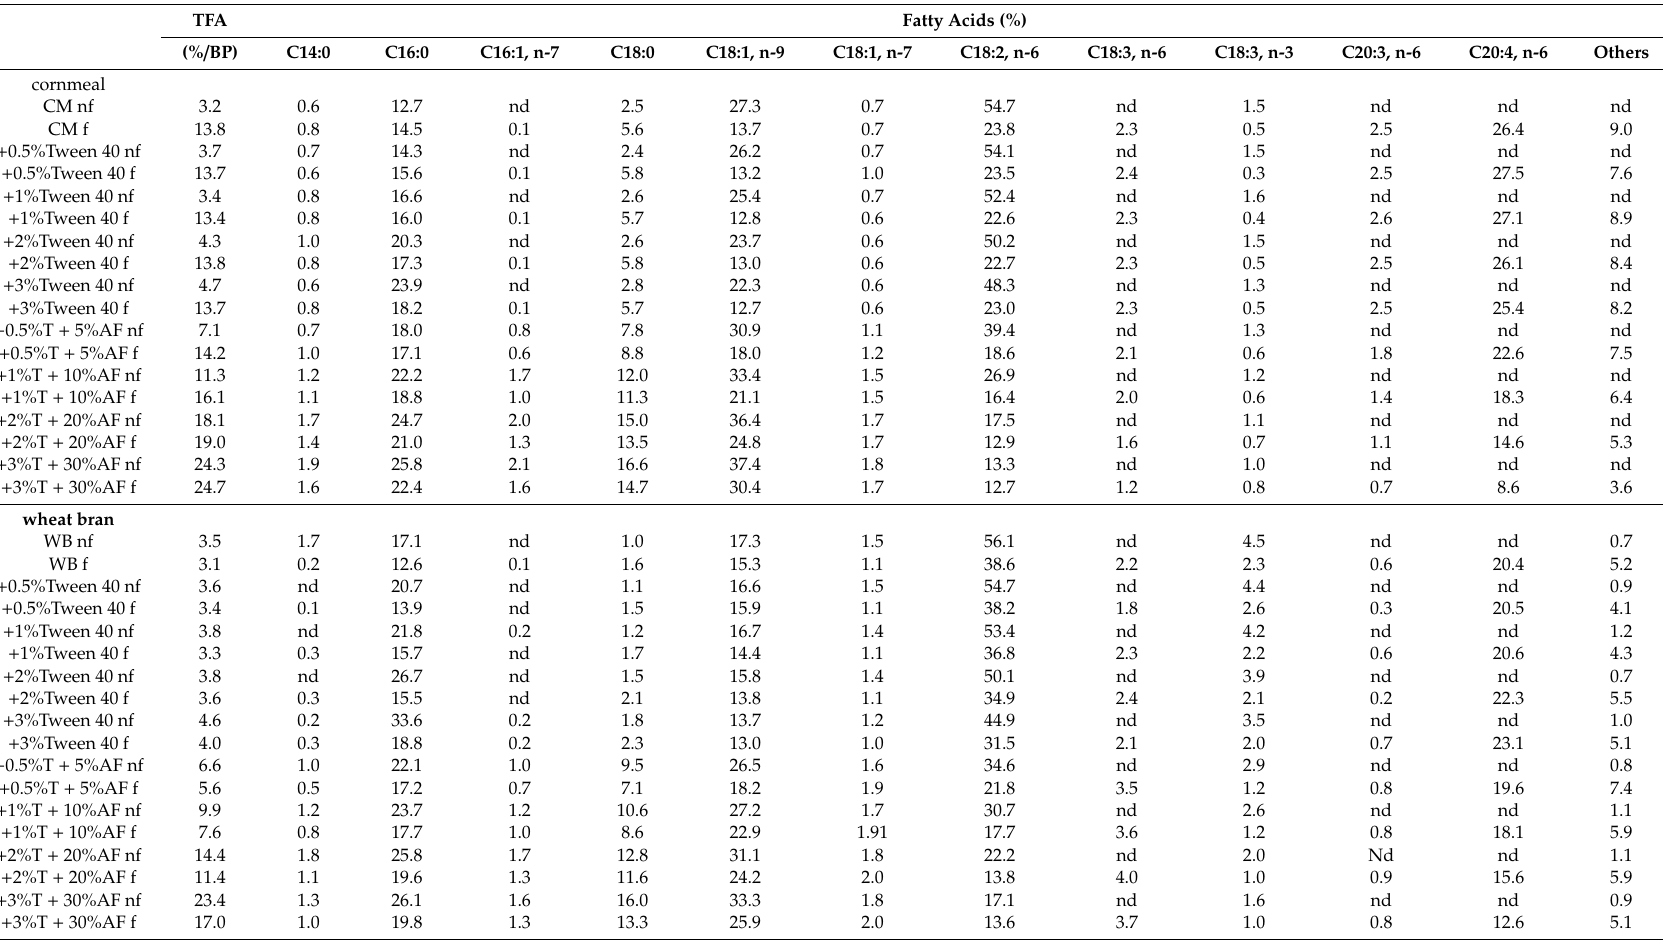
Table 4. Total fatty acid (TFA) content and fatty acid composition of non-fermented (nf) and fermented (f) cereal substrates (cornmeal—CM, wheat bran—WB) with the addition of di ff erent amounts of Tween 40 and animal fat (AF). The results are average of three independent biological replicates with α < 5%.